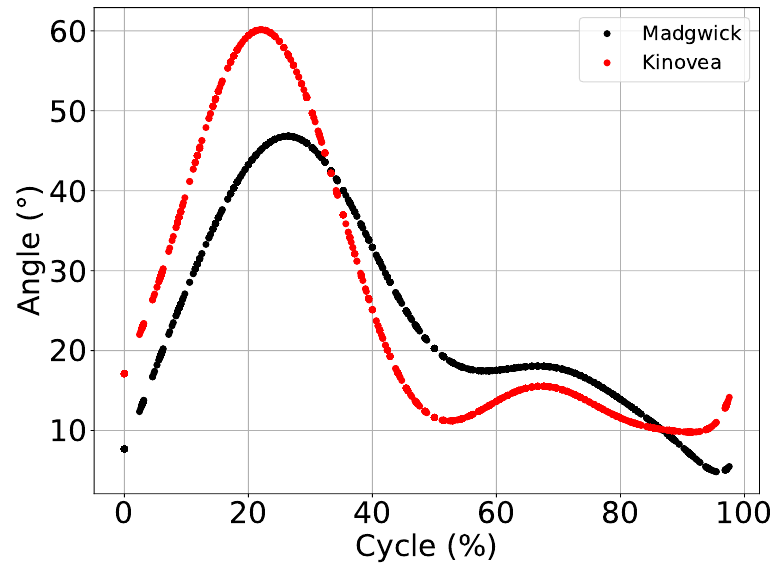
Figure 6. Comparison between Madgwick and Kinovea processed data. Figure shows the values of average ROM adjusted based on Min and Max estimates, based on the polynomial